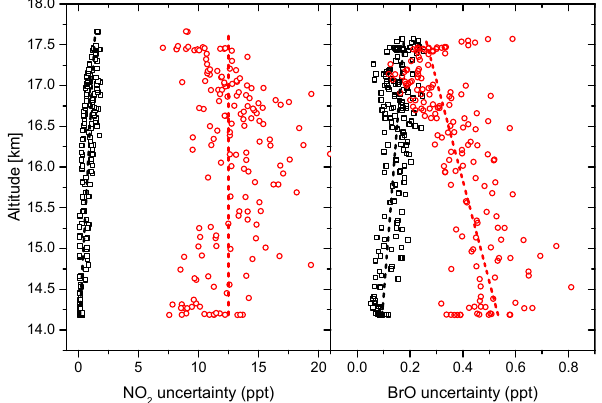
Figure 14. Uncertainty in the inferred NO 2 (left panel) and BrO (right panel) as a function of altitude due to uncertainties in the overhead (in black) and below the aircraft located column amounts (in red) of the respective gas. For the overhead column amounts, un- certainties of ± 15% were assumed for both NO 2 and BrO. The un- certainty due to NO 2 and BrO located below the aircraft is estimated by assuming uniform tropospheric mixing ratios of 15 and 0.5ppt, respectively (for details see Sect. 4.4). The dashed lines indicate the linear regressions, which was used in the error